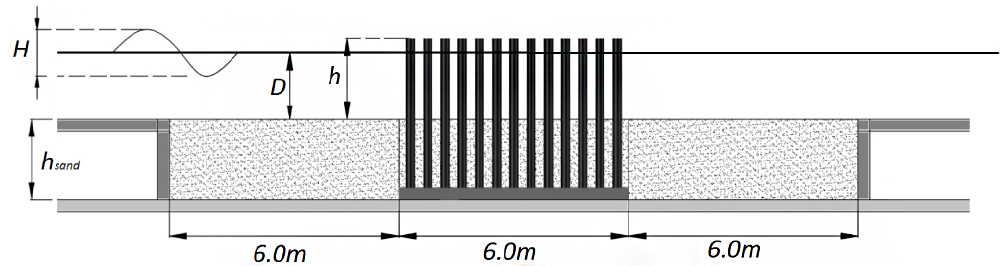
Figure 2. Random array of emergent cylinders, d = 2 . 0cm, protruding h = 21cm above the sand bed. Water depth was set at D = 0 . 16m for all